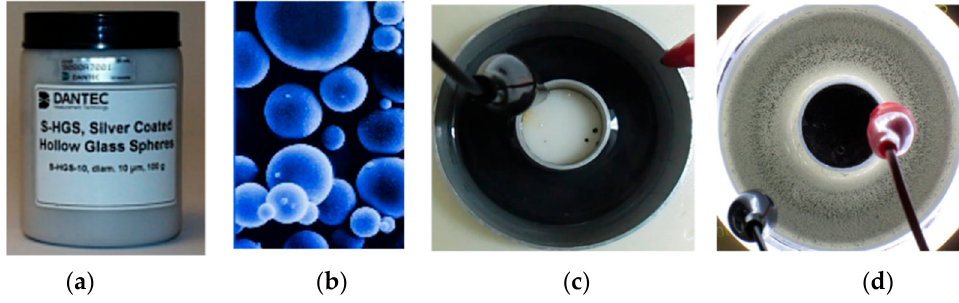
Figure 6. ( a ) Commercial packing of S-HGS particles, ( b ) S-HGS particles, ( c ) Pure electrolyte ( d ) Electrolyte seeded with S-HGS particles forming speckles.